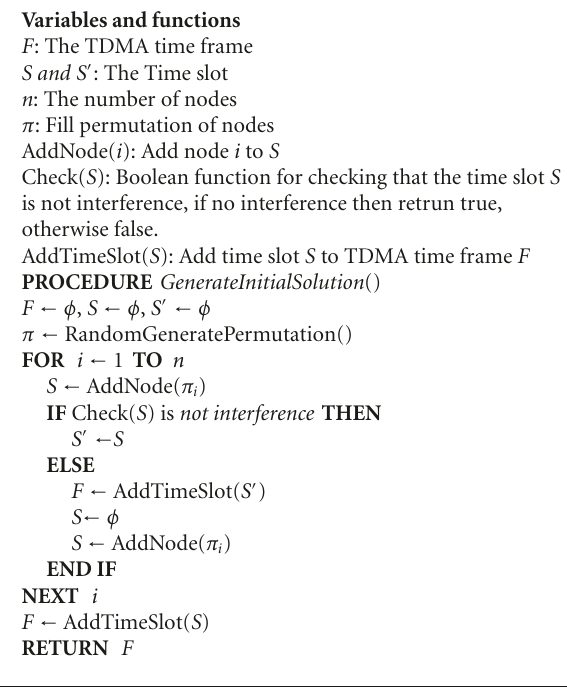
Algorithm 2: Pseudocode of the proposed operator of initial solution generation.